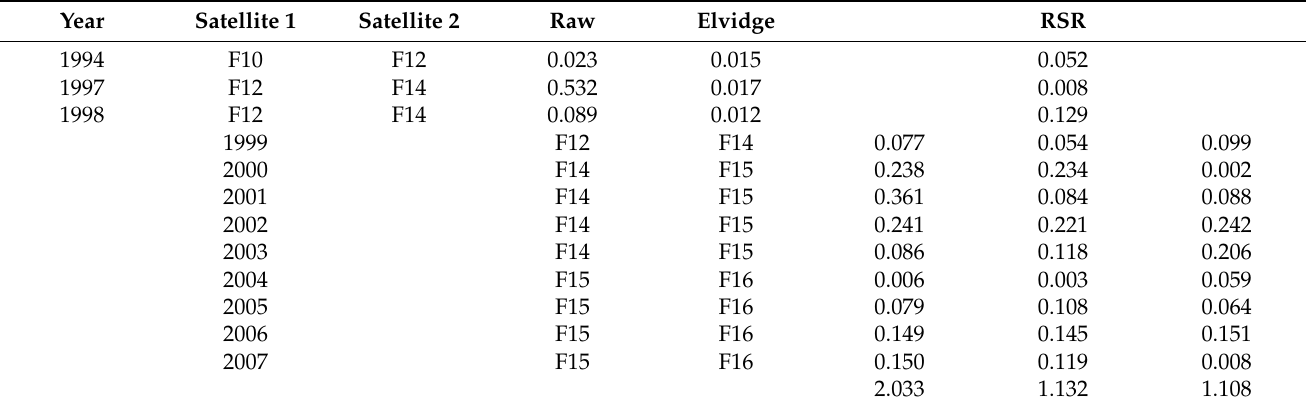
performed the Elvidge method. Table 3. The calibration errors of the NTL images based on different methods.